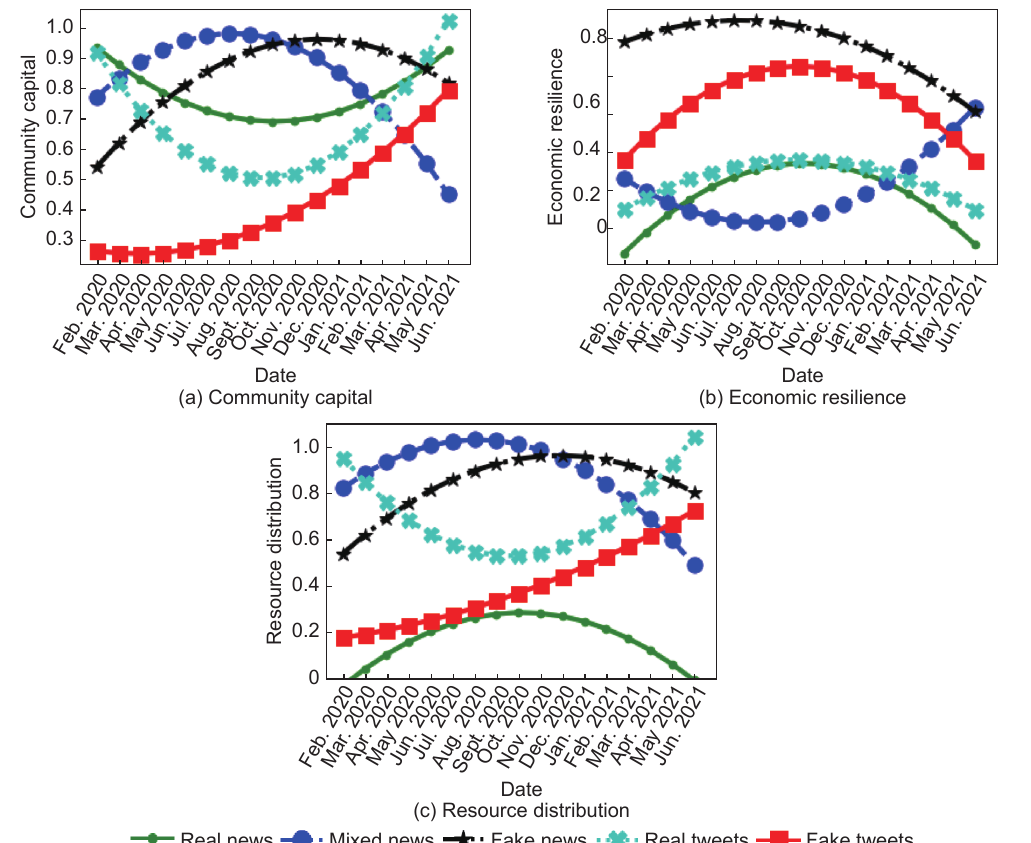
Fig. 7 Community capital, economic resilience, and resource distribution measured based on different types of news